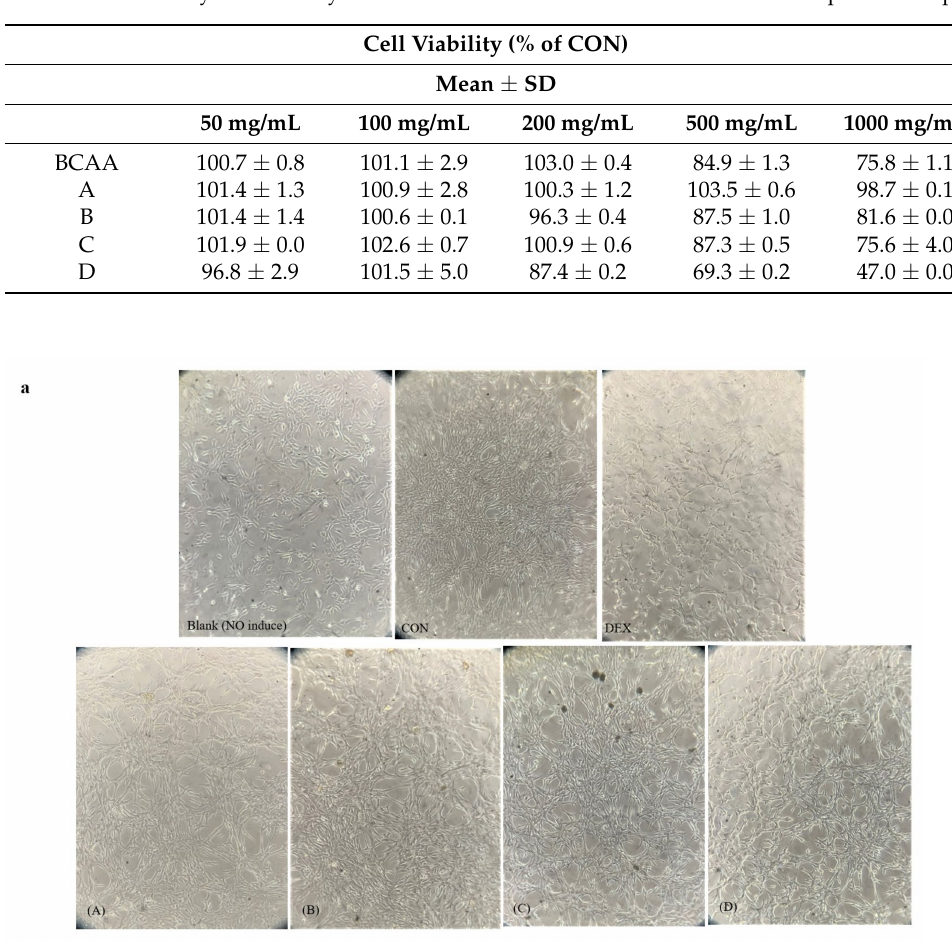
Table 2. Cell viability of C2C12 myotubes treated with different concentrations of rice protein samples.